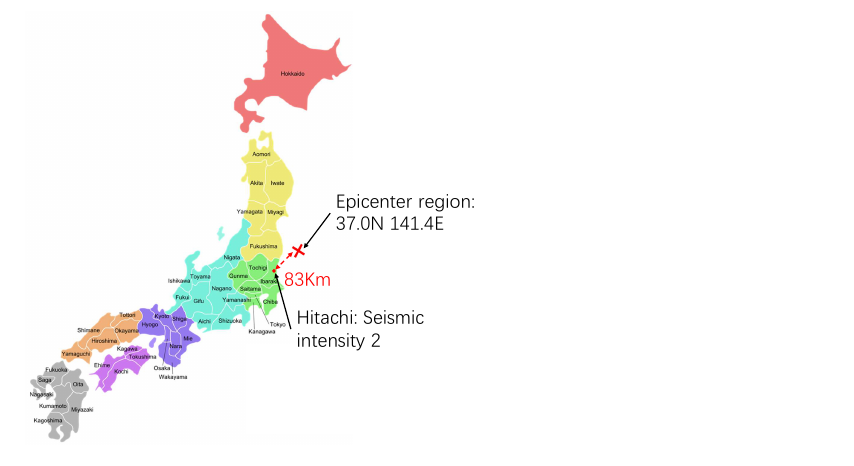
Figure 11. The maximum seismic intensity in Hitachi and the distance between Hitachi and the epicenter region off the coast of Fukushima